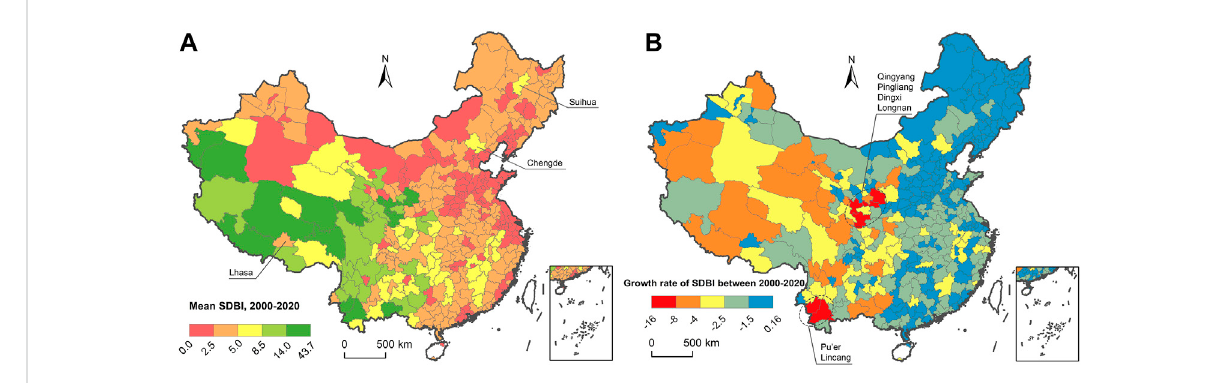
FIGURE 7 Sustainability assessment of coupled human and natural systems, 2000 – 2020.